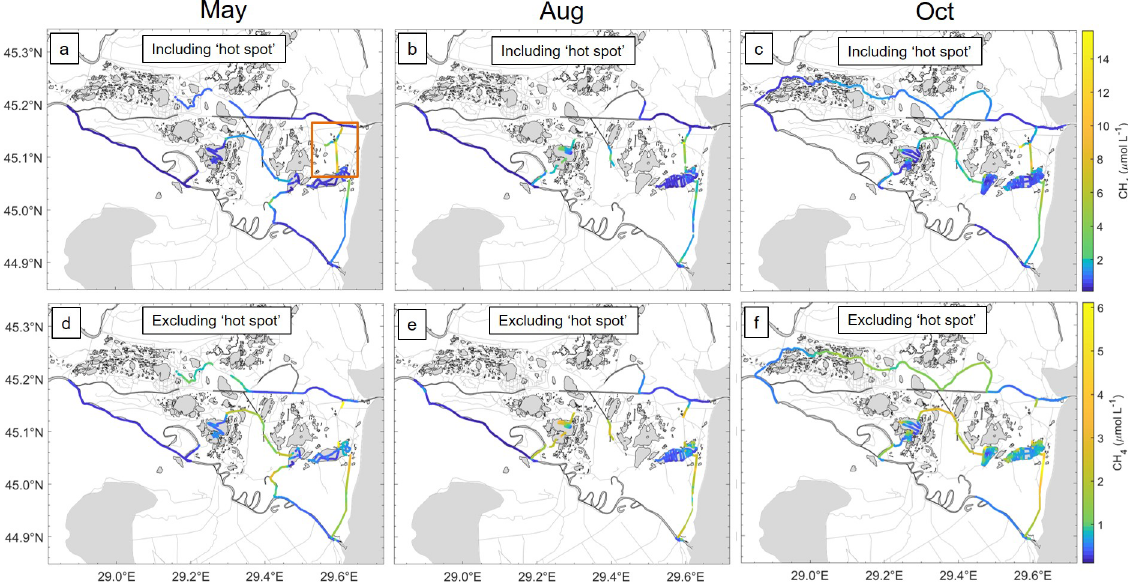
Figure 4. Spatial variability of CH 4 (µmolL − 1 ) over the three campaigns (May, August and October). Due to the hot spot (Fig. 1b2) channel influencing the overall concentrations, panels (a) – (c) include the hot spot measurements, reaching a maximum of 15.6 (µmolL − 1 ), with a red box in panel (a) showing region of the hot spot. (d–f) Spatial concentration of CH 4 (µmolL − 1 ) excluding the hot spot, with a maximum of 6.12µmolL − 1 . Note the change and non-linear colouring of the colour bar for clearer overall CH 4